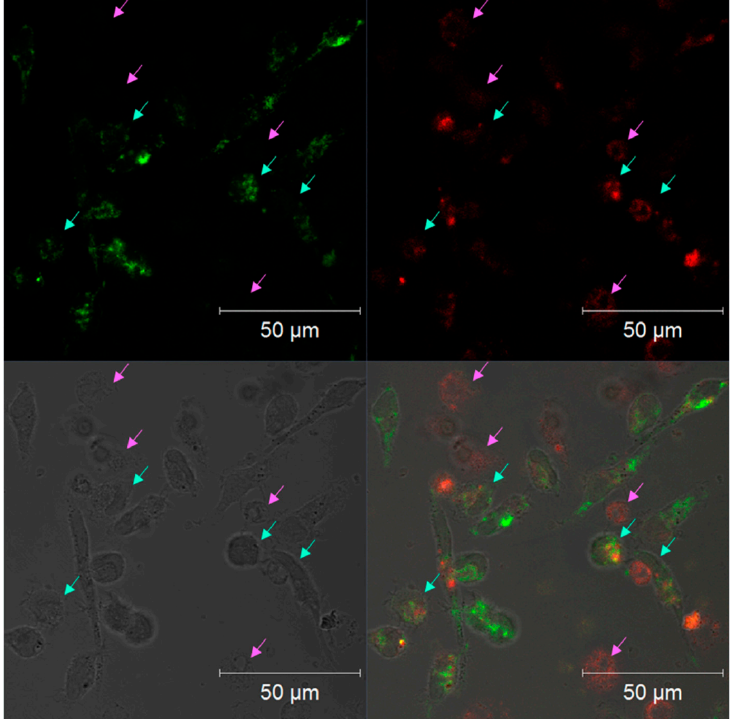
Figure 3. Confocal micrograph of CD14+ human monocytes stained with MitoTracker Orange CMTMRos showing protoporphyrin IX (PpIX) autofluorescence. MitoTracker Orange CMTMRos staining is shown in green, and PpIX autofluorescence is shown in red. MitoTracker-high/PpIX+ cells are marked with light-blue arrows. MitoTracker-low/PpIX+ cells are marked with purple arrows. Shown is a representative example of a field of view. Cells with different levels of mitochondrial membrane potential, revealed by the staining, are shown with arrows of different colors. Upper- left quadrant: MitoTracker fluorescence; upper-right quadrant: PpIX autofluorescence; lower-left quadrant: phase contrast; lower-right quadrant: combined